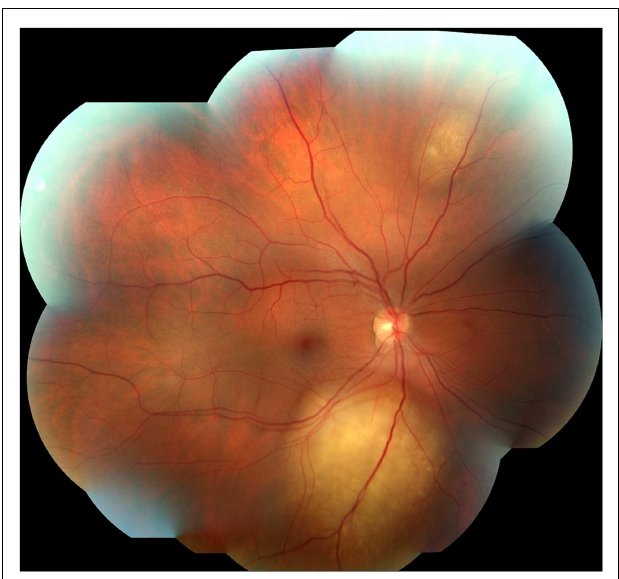
FIGURE 3 | Photograph of the right fundus, with evidence of two uveal metastases .